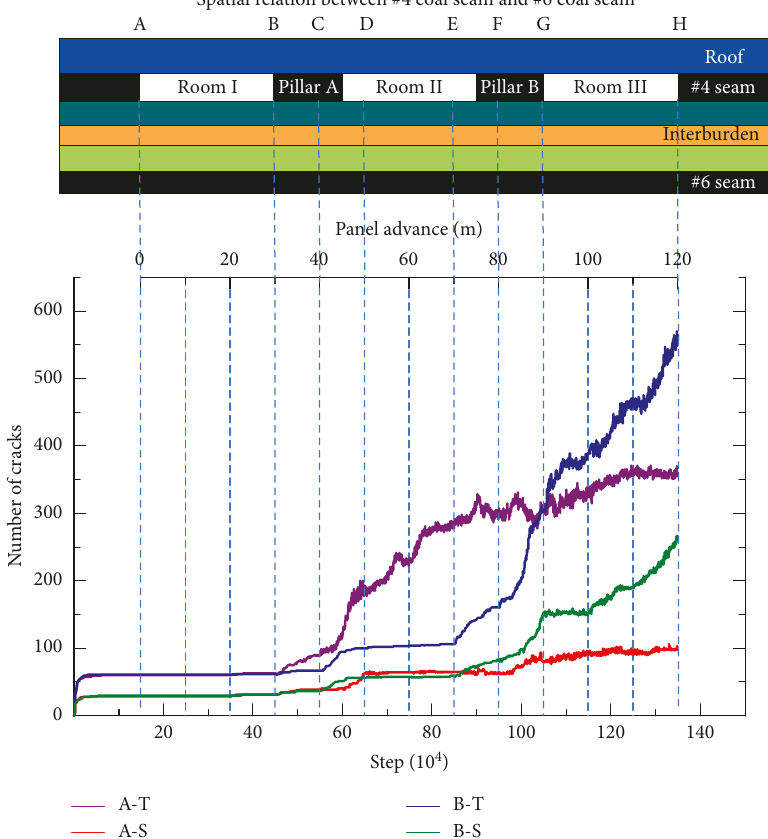
Figure 7: Number of tensile and shear cracks versus model time steps.